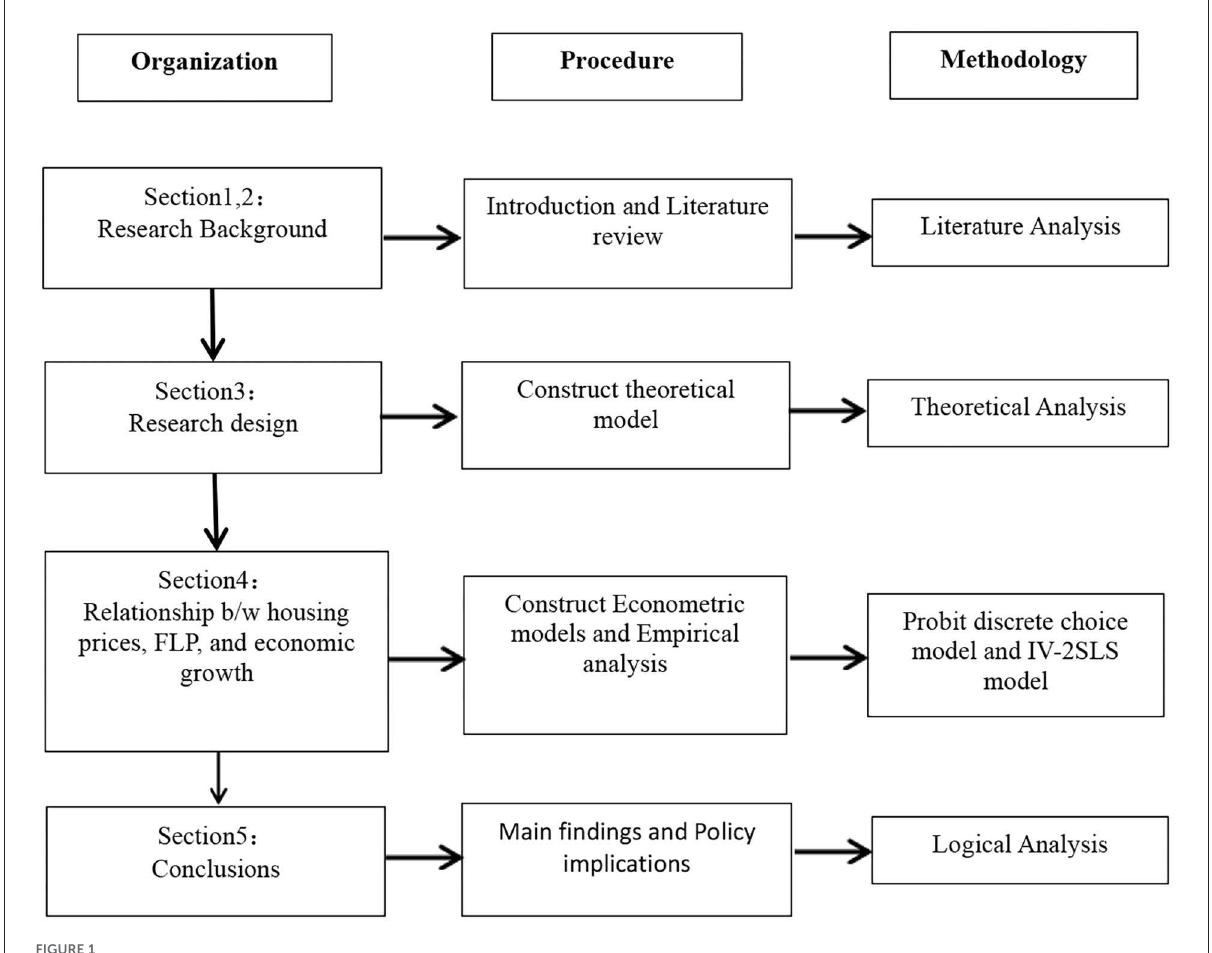
FIGURE1 Organization of the